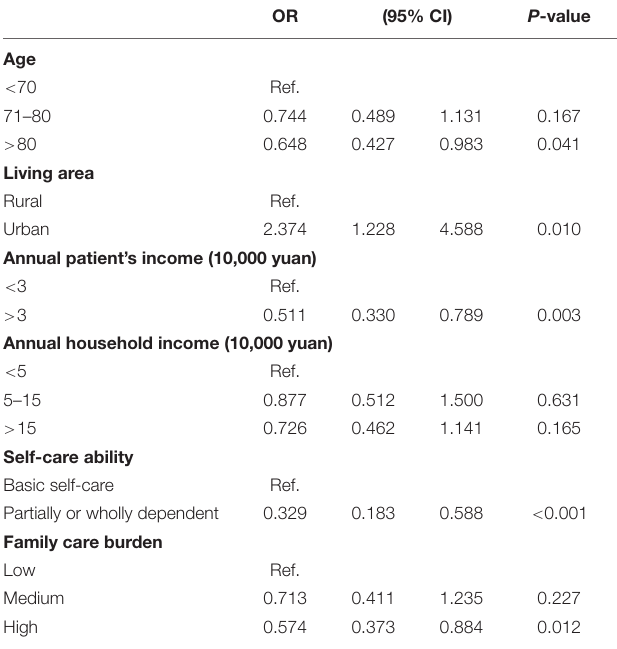
TABLE 3 | Logistic regression models for the caregiving status of AD patients ( N =